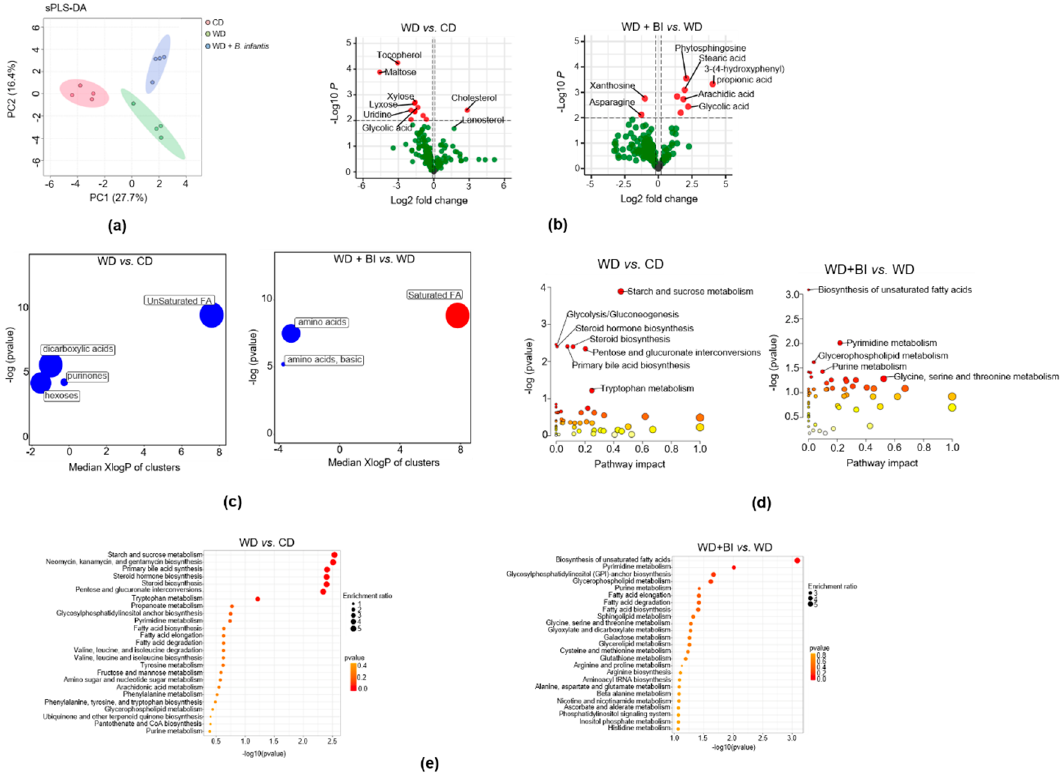
Figure 3. Untargeted metabolomics study of cecal content. Mice were fed a WD and treated with or without B. infantis: ( a ) sPLS-DA analysis of cecal metabolites clustered differently; ( b ) Volcano plots represent the cecal metabolomics profile between WD vs. CD (n = 4) and WD + B. infantis vs . WD (n = 4). The red color represents the fold changes of > 2 with a p -value < 0.05; ( c ) ChemRICH metabolite set enrichment statistics plot. The node color shows increased (red) or decreased (blue) metabolite sets. Only enrichment clusters are shown significantly different at p < 0.05 (The node sizes represent the total number of metabolites in each cluster set); ( d ) The pathway impact and ( e ) pathway analysis impacts were shown between WD vs. CD (n = 4) and WD + B. infantis vs. WD (n =